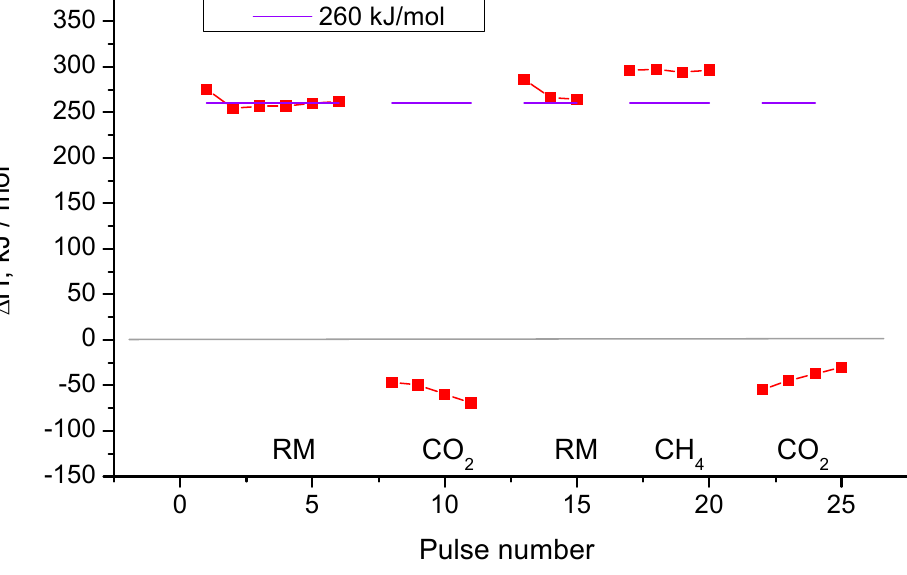
Figure 6. Measured heat effects during pulses of different compositions at 773 K.